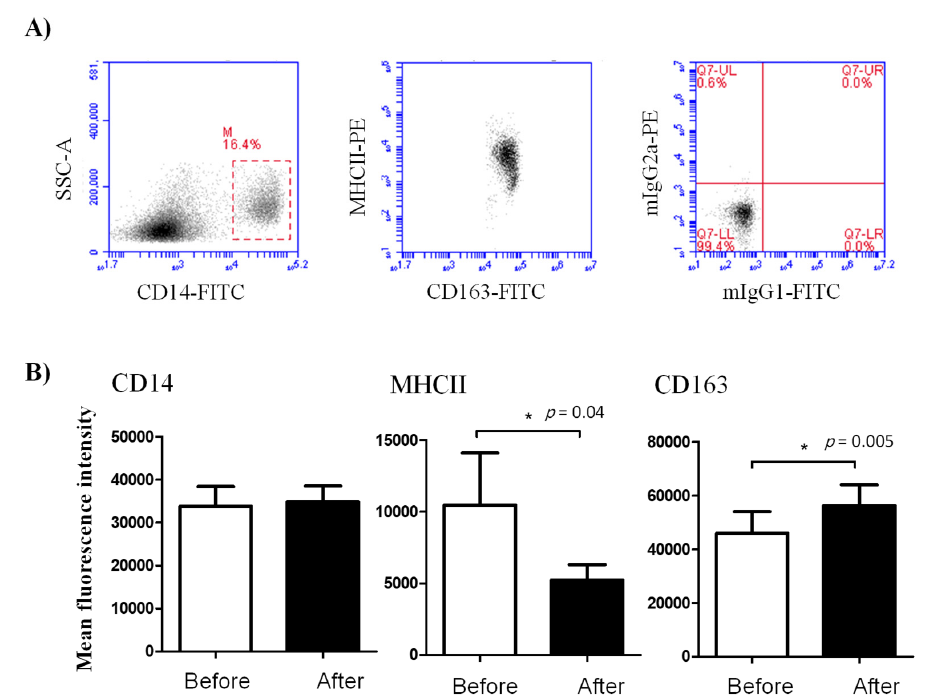
Figure 3. Ex vivo analysis of the abundance of the cell surface molecules CD14, MHC-II, and CD163 on camel blood monocytes. Leukocytes were labeled with mAbs to the cell antigens CD14, MHCII, and CD163, and the cell membrane fluorescence was measured on the flow cytometer. ( A ) After the identification of monocytes, based on their positive staining with CD14, the expression levels (MFI) of CD14, MHC-II, and CD163 were estimated for samples collected before and after treatment with lornoxicam. ( B ) Differences between the means were considered significant (*) if p < 0.05.